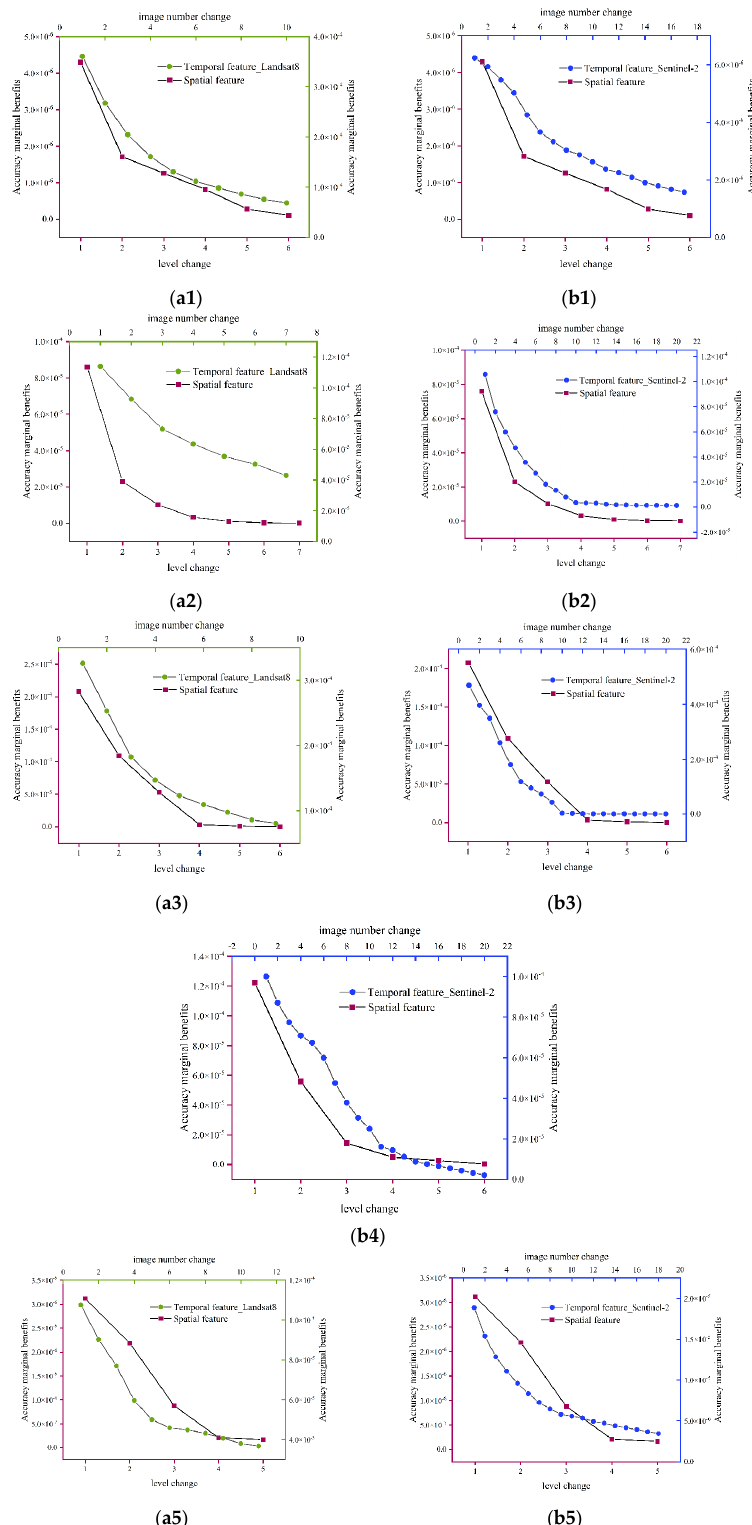
Figure 11. ( a1 , b1 , a2 , b2 , a3 , b3 , b4 , a5 , b5 ) are the accuracy marginal benefits for each of the five study areas. Among them, ( a1 − a3 , a5 ) is the comparison of the marginal benefits of spatial features and Landsat-8 temporal features. The marginal benefits of SA4 are not compared due to the small num- ber of Landsat-8 images that met the requirements during the time period of the SA4 experiment. ( b1 − b5 ) is a comparison of the marginal benefits of the spatial features and the temporal features of Sentienl-2. Comparing the AMB of the spatial and temporal features, we find that the AMB of spatial features is within the range of 9.27 × 10 − 5 to 2.25 × 10 − 7 , the AMB of temporal features is within the range of 1.53 × 10 − 4 to 3.03 × 10 − 5 , and the former is lower than the latter, which indicates that the accuracy would benefit more from increasing the LoD of temporal fea- tures than spatial features of similar data volume. That means the efficiency of the contri- bution to accuracy from temporal feature changes will be higher than the contribution to accuracy from spatial feature changes. This further demonstrates that the classification performance of temporal features is superior to that of spatial features under this experi- mental condition.